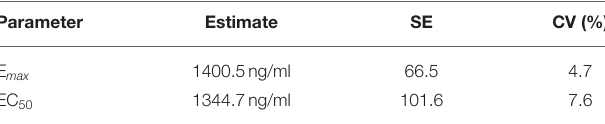
TABLE 2 | Summary of pharmacodynamic efficacy parameters for apixaban anti-Xa activity following intravenous administration, mean dose 0.18 mg/kg. Parameter